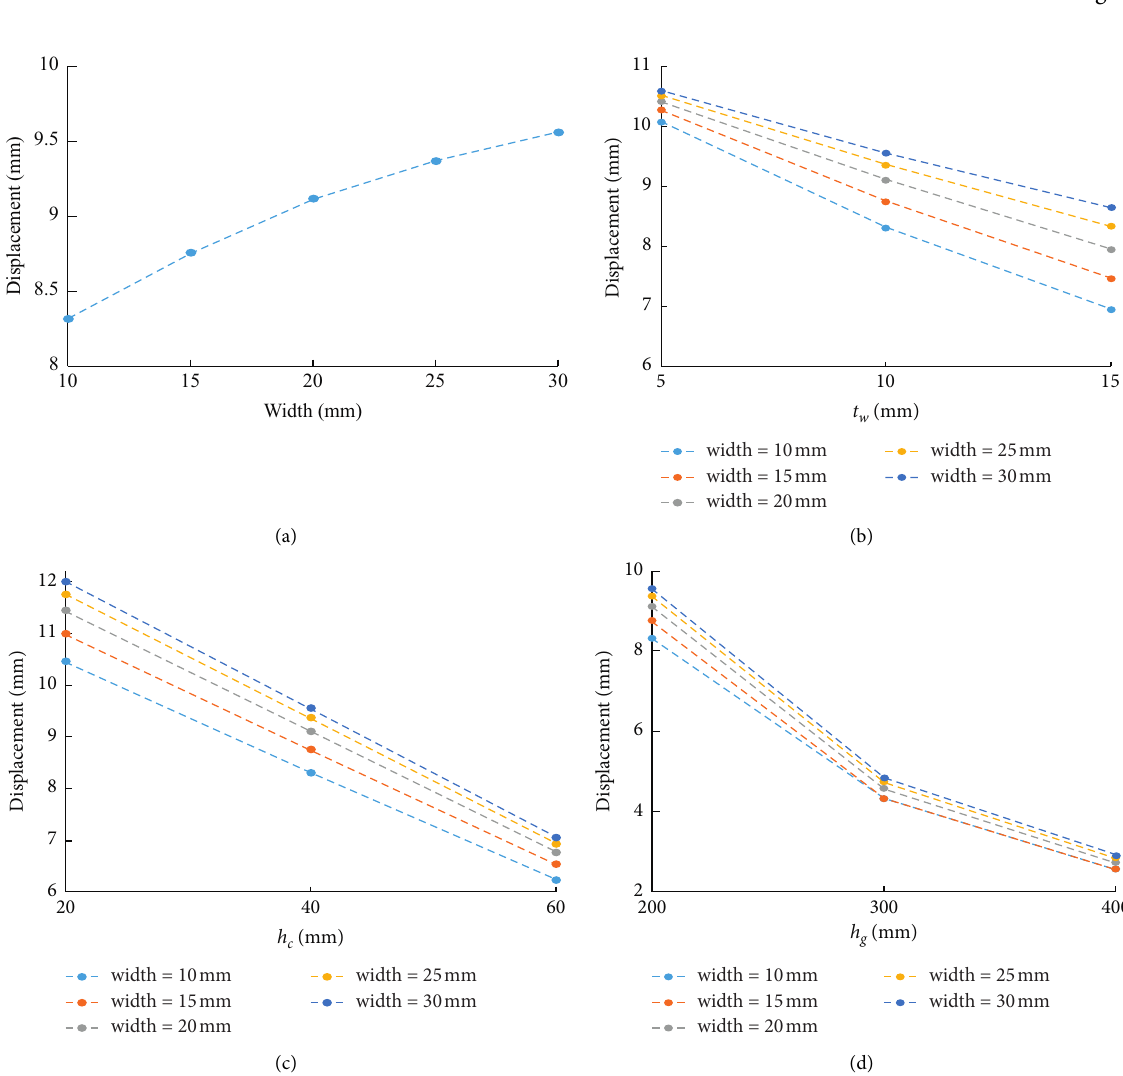
AREAS TYPE NUM PRES-NORM